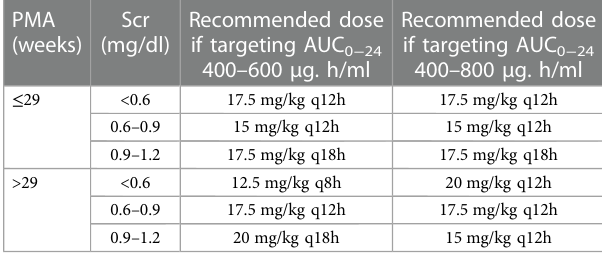
TABLE 5 Recommended doses using our model depending on the target selected. PMA